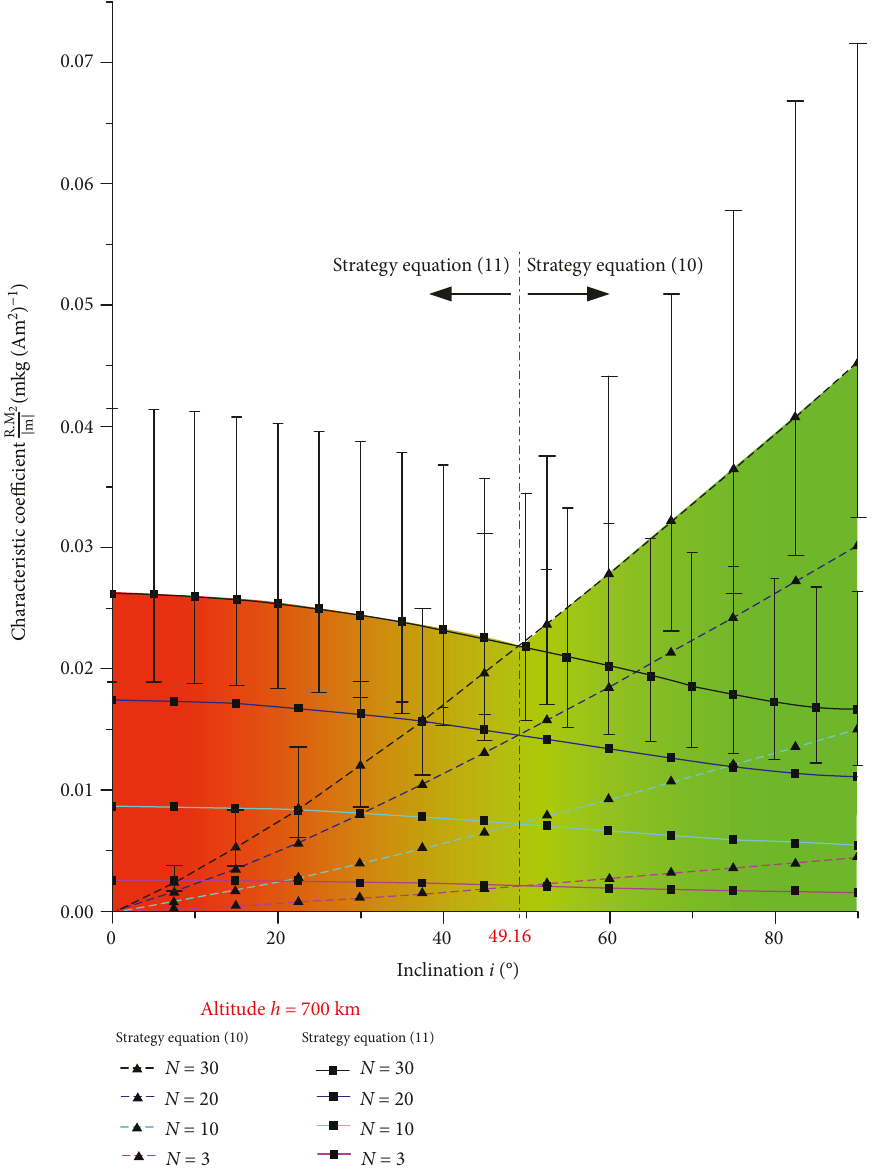
Figure 14: Deorbiting capability within di ff erent deorbiting orbital periods N required (example